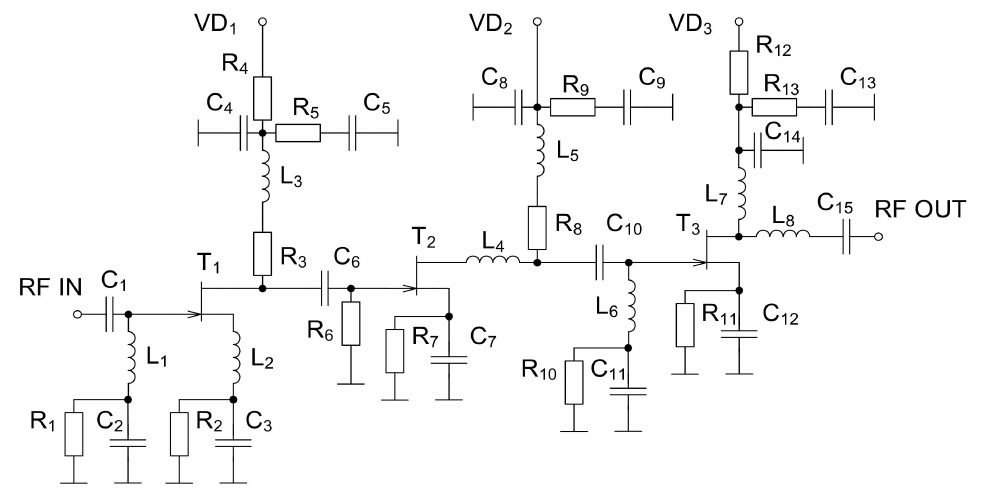
Figure 10. Electrical scheme of the three-stage LNA developed using the first release of PDK.